Question: In one sentence, what is this figure communicating?
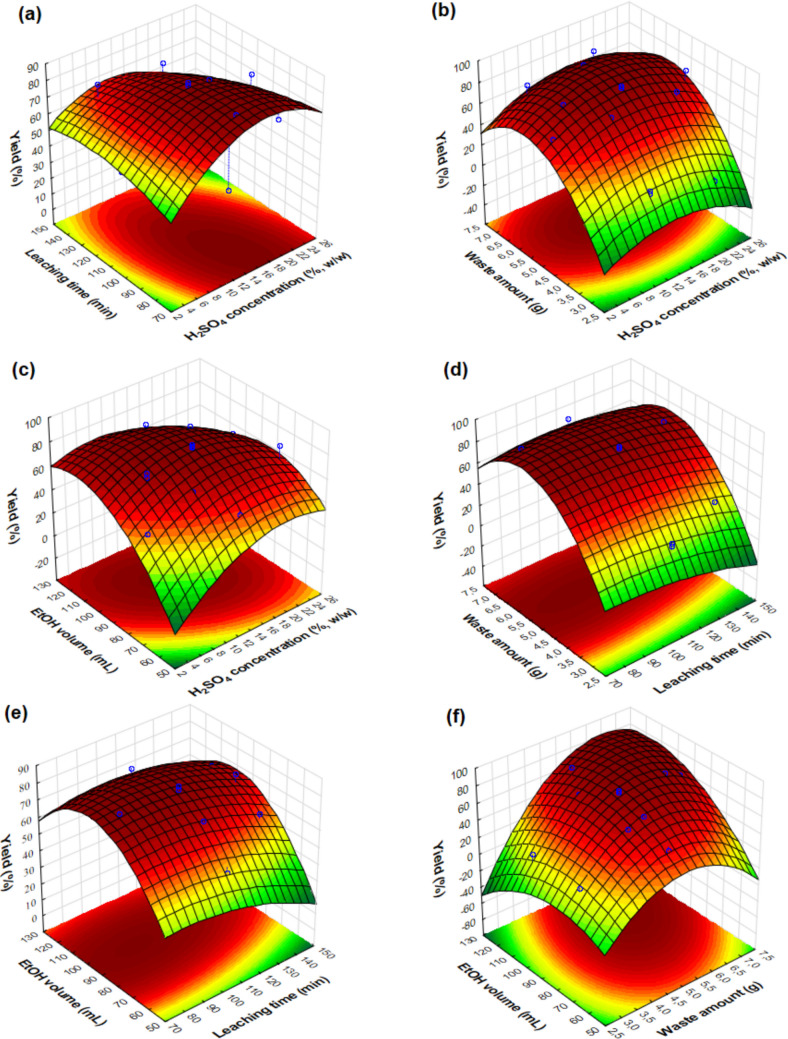
Answer: Response surfaces based on the DED matrix experiments for the ferrous sulfate yield as a function of ( a ) leaching time and H 2 SO 4 concentration, ( b ) waste amount and H 2 SO 4 concentration, ( c ) EtOH volume and H 2 SO 4 concentration, ( d ) waste amount and leaching time, ( e ) EtOH volume and leaching time, and ( f ) EtOH volume and waste amount. All the factors were fixed at the center points